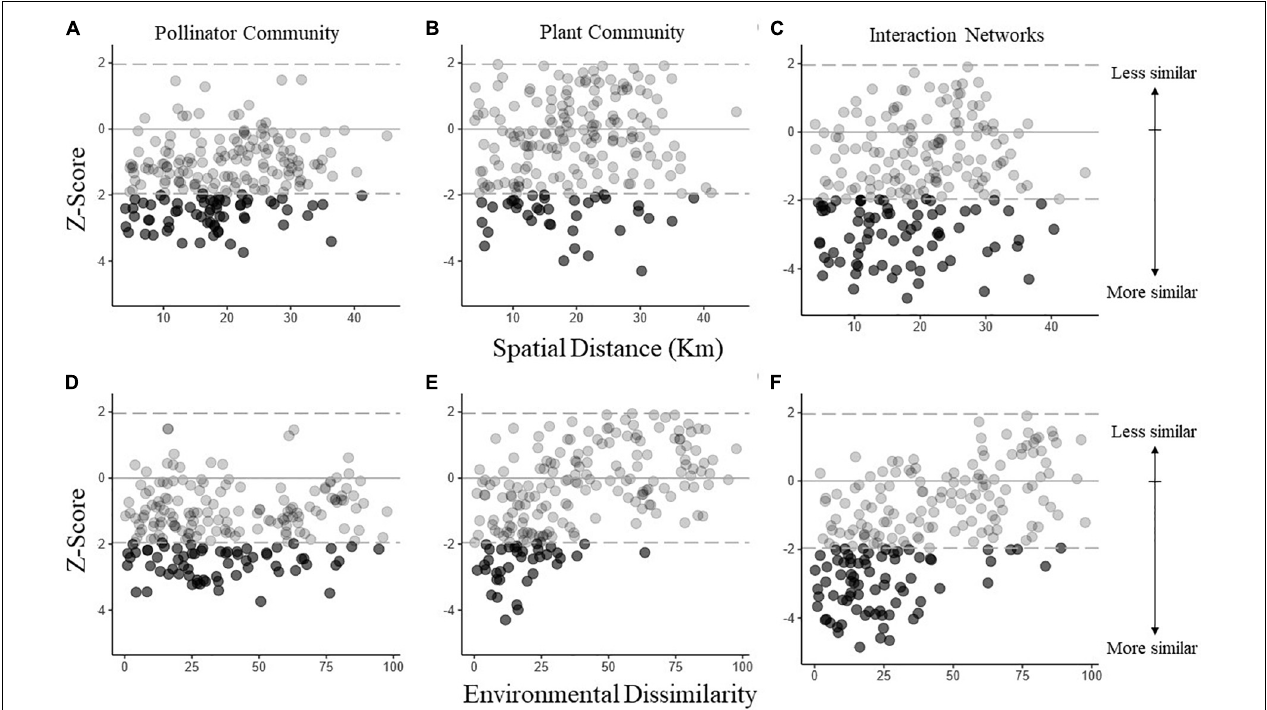
FIGURE 3 | Dissimilarity in the composition of pollinators (A,D) , plants (B,E) , and their interactions (C,F) networks as a function of spatial (A–C) and environmental distance (D–F). To reduce the effect of differing α diversities, we calculated z-scores as a measure of deviation from randomness. Z -scores were given as ( β emperical – mean( β resampled ))/ SD resampled , where β emperical is the empirical similarity between two networks, mean( β resampled ) and SD resampled are the mean and standard deviation of the similarities when performing 1000 random assortments of species and interactions, respectively. Positive and negative z -scores signify higher and lower similarity, respectively, than expected from random distributions of species and interactions. Filled circles indicate that a given empirical pairwise comparison differed significantly from the resampled values, and gray dashed lines mark the boundary between 1.96 and -1.96.